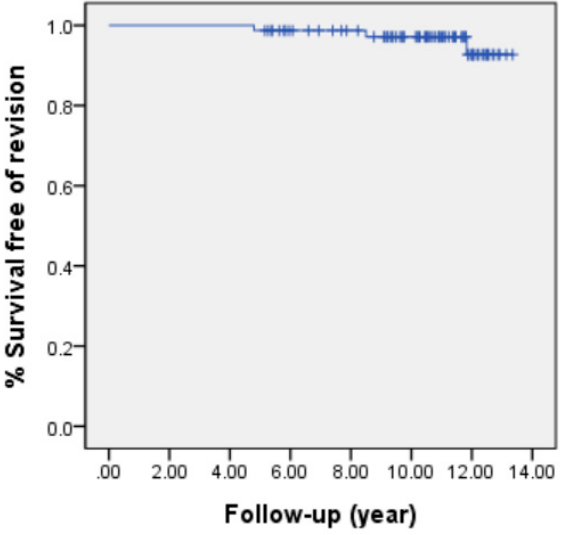
Figure 2. Prosthesis survival after total knee arthroplasty (TKA) in hemophilic arthropathy.